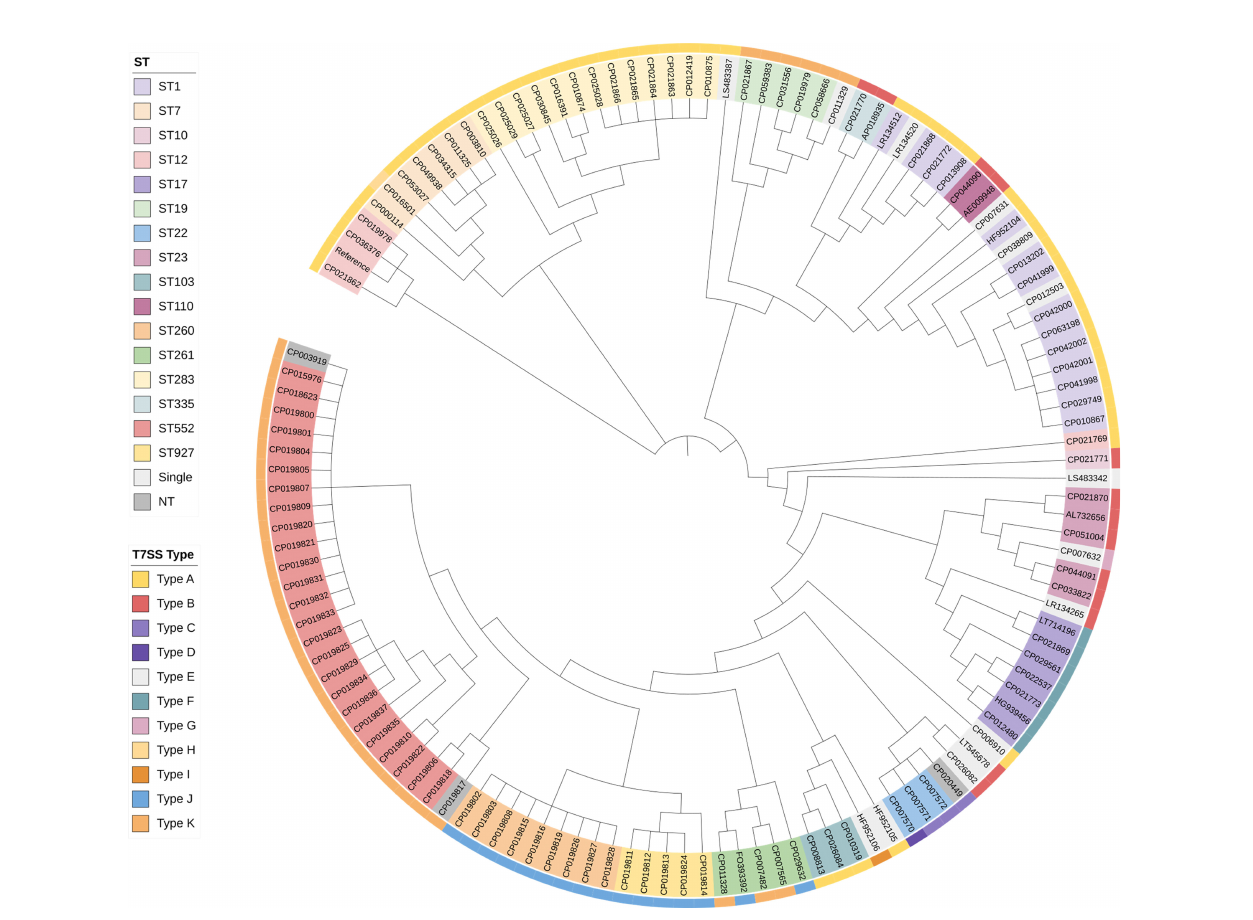
FIGURE 3 | Phylogenetic relationship of 128 complete S. agalactiae genomes in the public dataset. Strains with identical STs are indicated by the same color in the phylogenetic tree. The outer ring indicates different T7SS types characterized in this study. Color coding is de fi ned in the inset. Single, STs represented by a single genome in the database; NT,